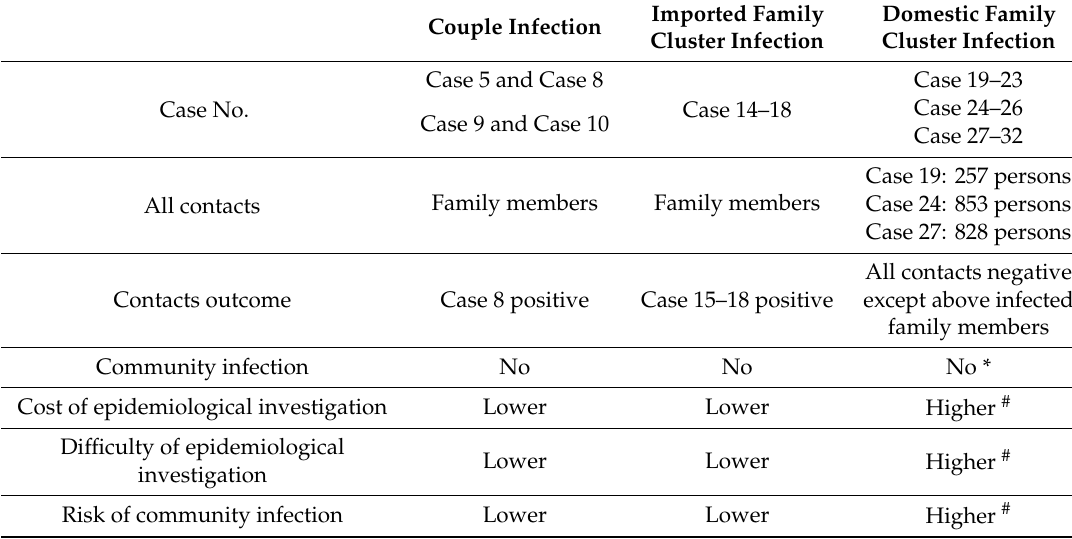
Table 2. Comparison of the characteristics and outcome of three types of family infections with COVID-19 in